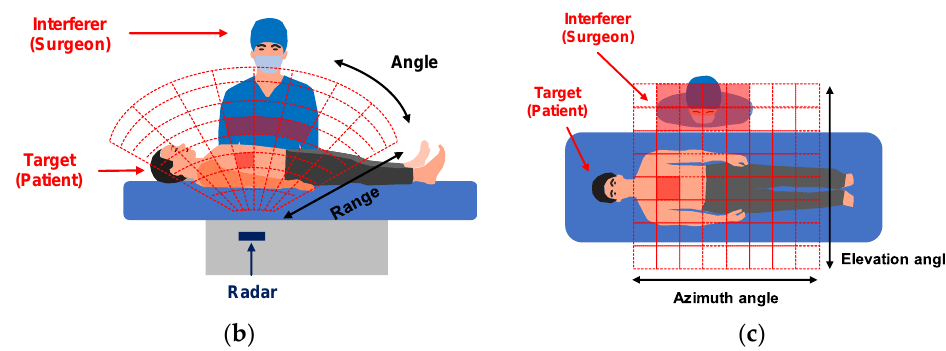
Figure 1. Scenario for monitoring vital signs of the patient lying on the surgical bed. ( a ) The used radar module; ( b ) is side–view; ( c ) and